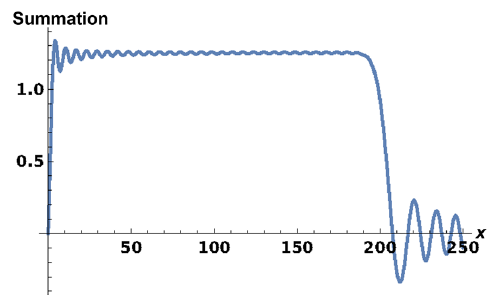
Figure 4. The sum of the first 200 spherical Bessel functions of argument x , weighted as in Equation (5), from x = {1,250}. This illustrates a general property of the sums resembling a bandlimited interpolation function within a range where x ≤ N .